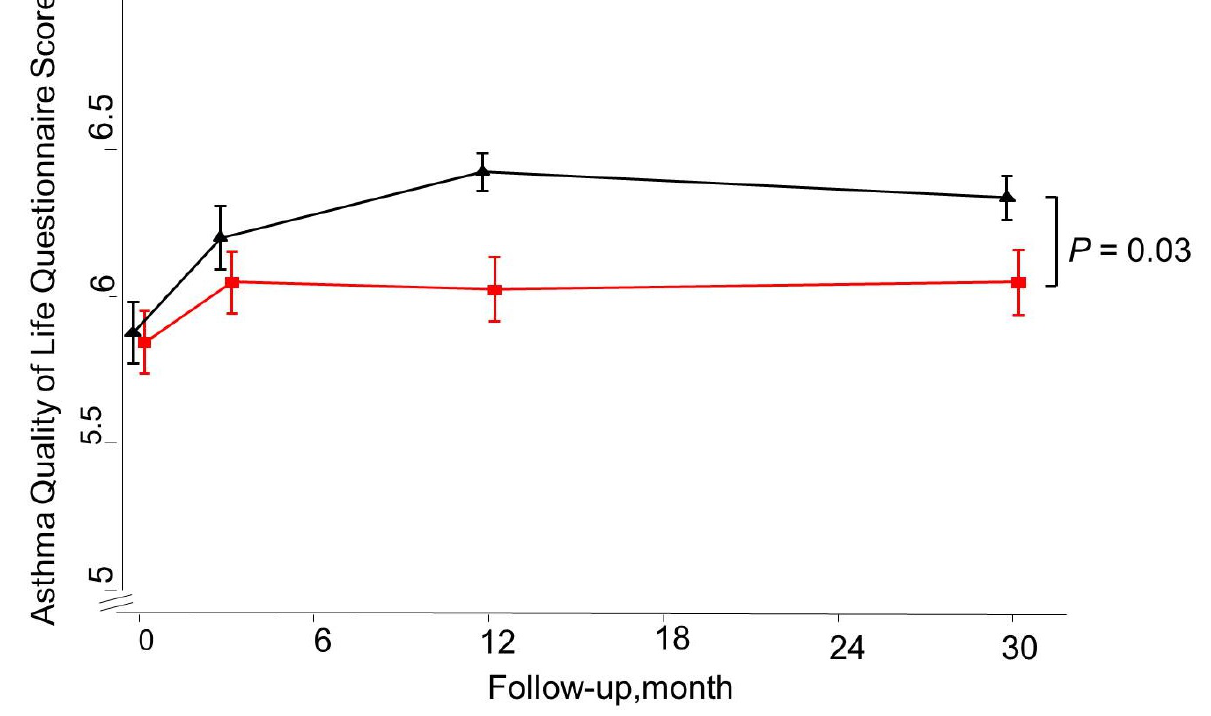
Figure 4. Mean Asthma Quality of Life Questionnaire score for the Internet and Usual care group as measured at 0, 3, 12, and 30 months of